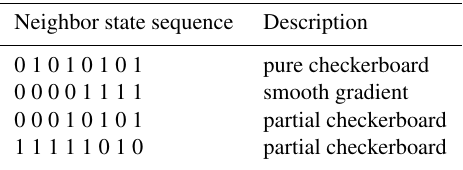
Table 1. Examples of binary sequences that describe the relative states of the eight adjacent neighbors relative to a given center point on a rectilinear grid (see